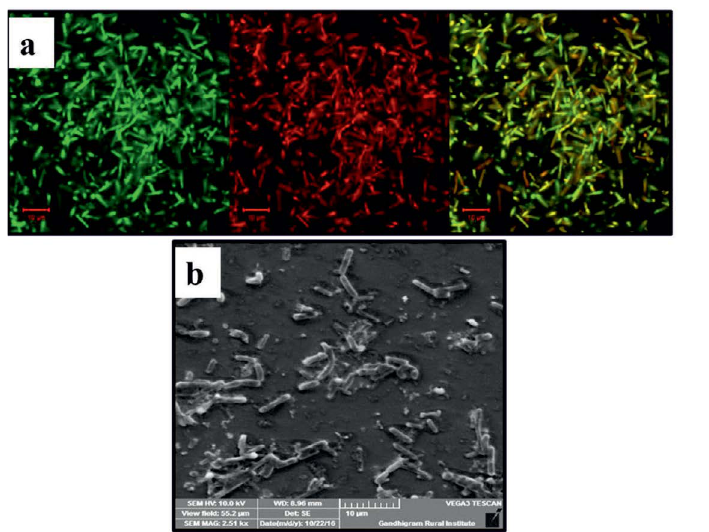
Fig. 1 . Phylogenetic tree based on 16S rRNA sequences